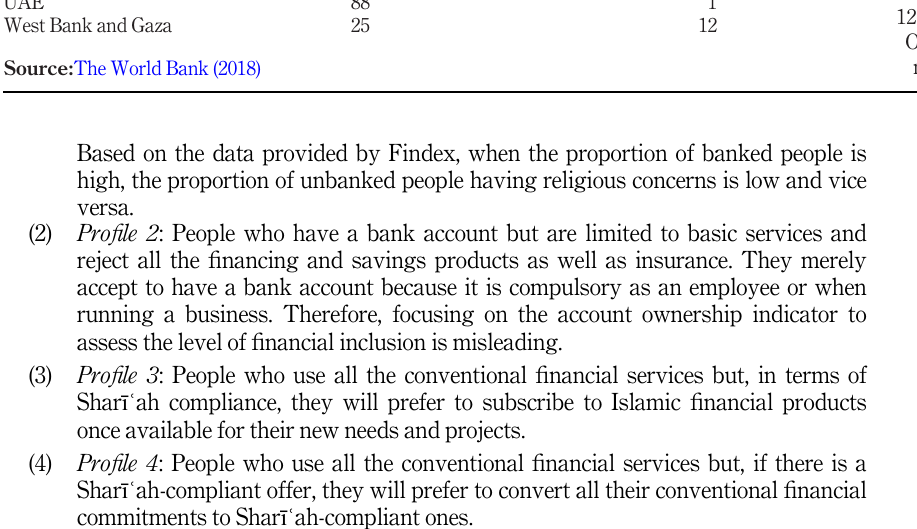
Table I. Financial inclusion